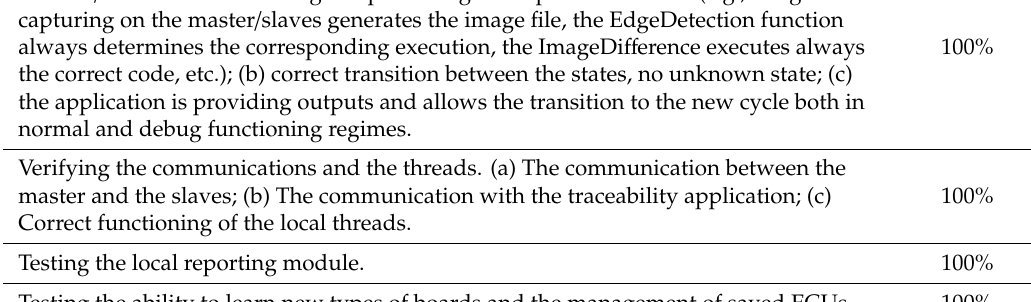
Table 1. Other results of the testing procedure.